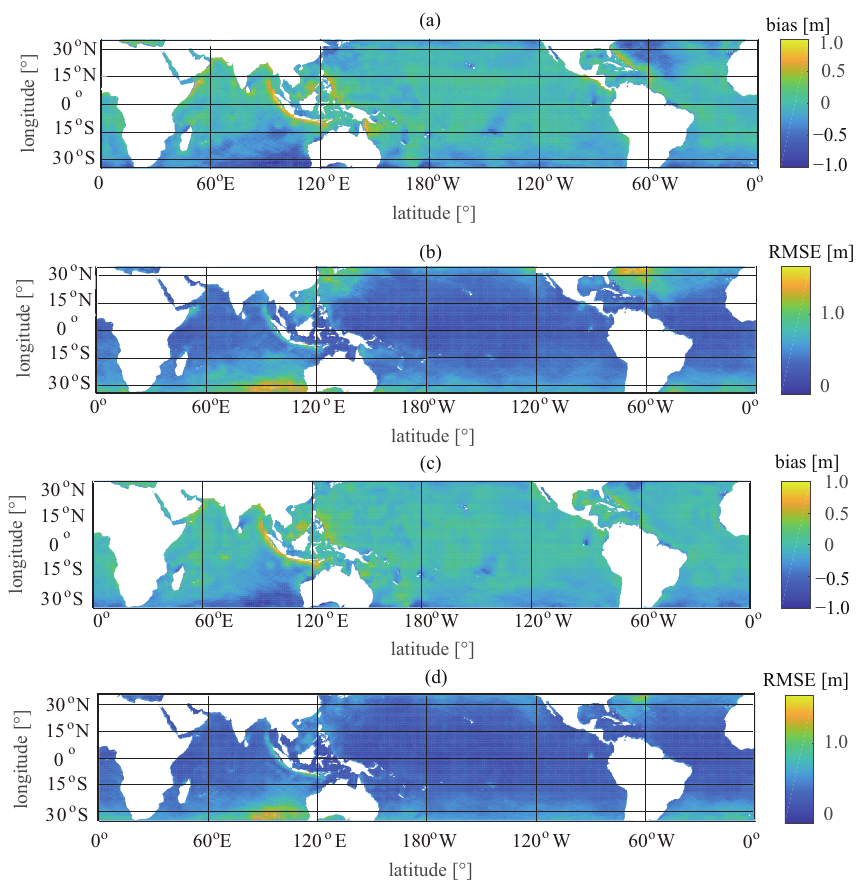
Figure 14. Illustration of global monthly gridded retrieval performance maps. ( a ) Gridded biases and ( b ) RMSEs when wind speed was not considered as an input parameter; ( c ) gridded biases and ( d ) RMSEs when wind speed was considered as an input